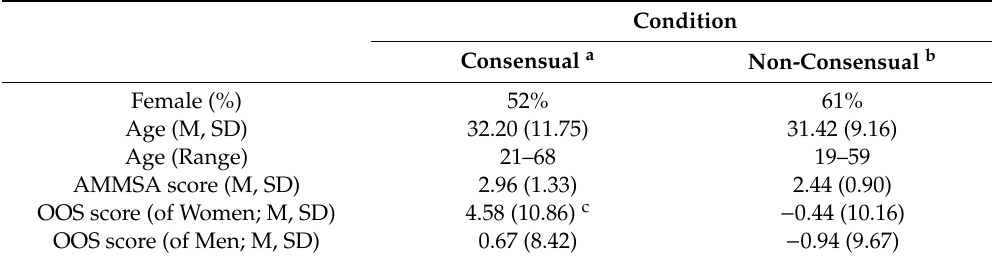
Table 1. Participant characteristics and questionnaire